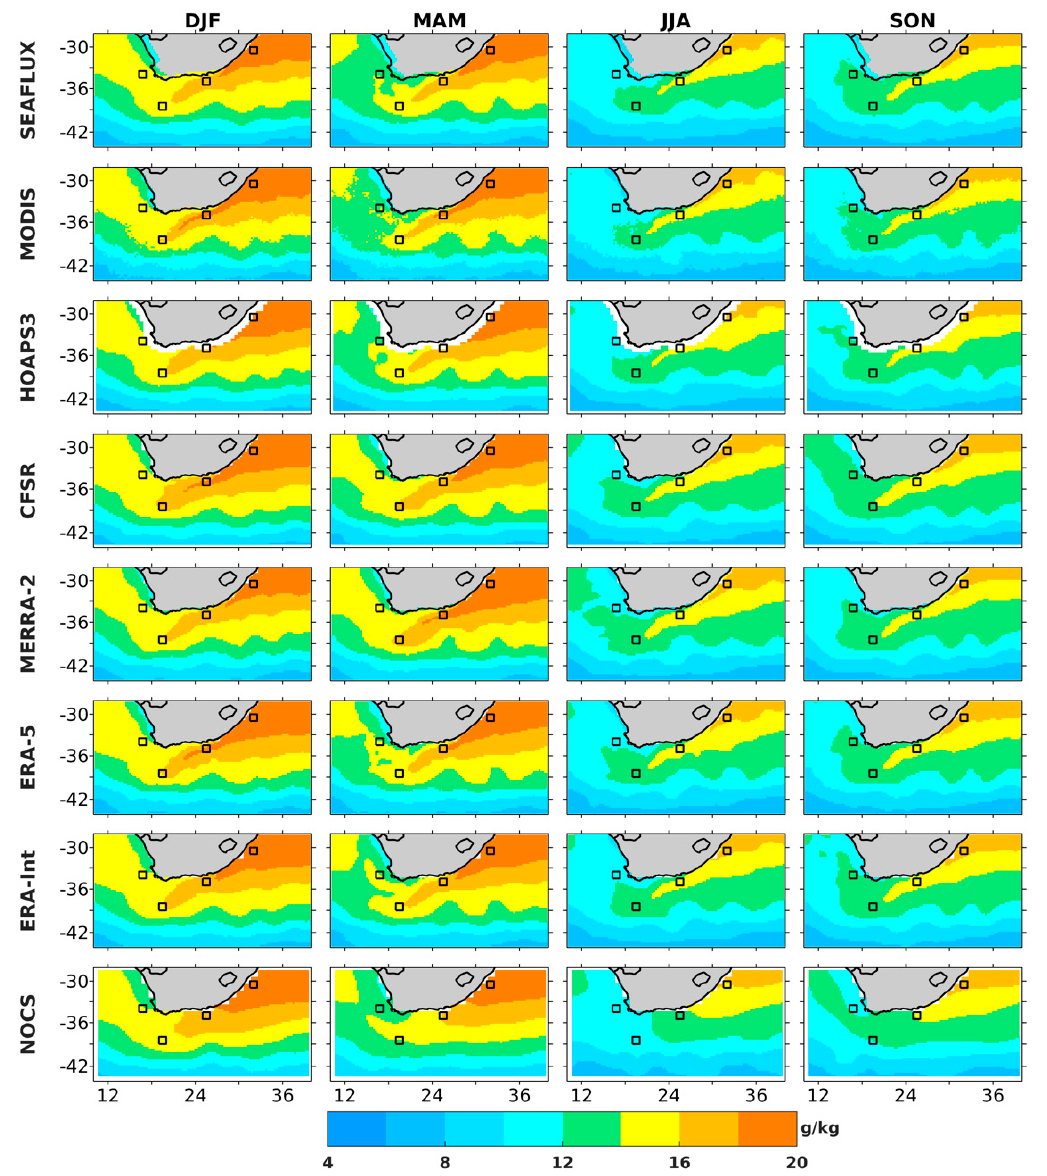
Figure 11 : Seasonal average of surface specific humidity (Qss, g/kg) of MODIS, SEAFLUX, HOAPS3, CFSR, MERRA-2, ERA-Interim and NOCS. From left to right austral summer (DJF), austral autumn (MAM), austral winter (JJA) and austral spring (SON). Black squares represent the four locations taken for the study.